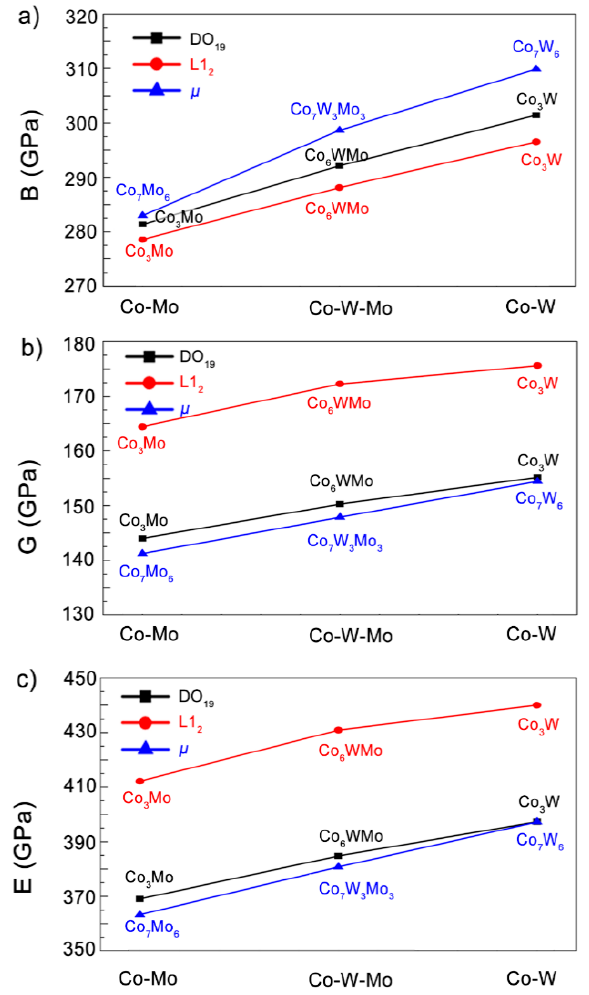
Figure 2. The comparisons of the ( a ) bulk ( B ), ( b ) shear ( G ) and ( c ) Young’s ( E ) moduli of the Co– W/Mo compounds in the DO 19 , L1 2 and μ structures. Co–W/Mo compounds in the DO 19 , L1 2 and µ